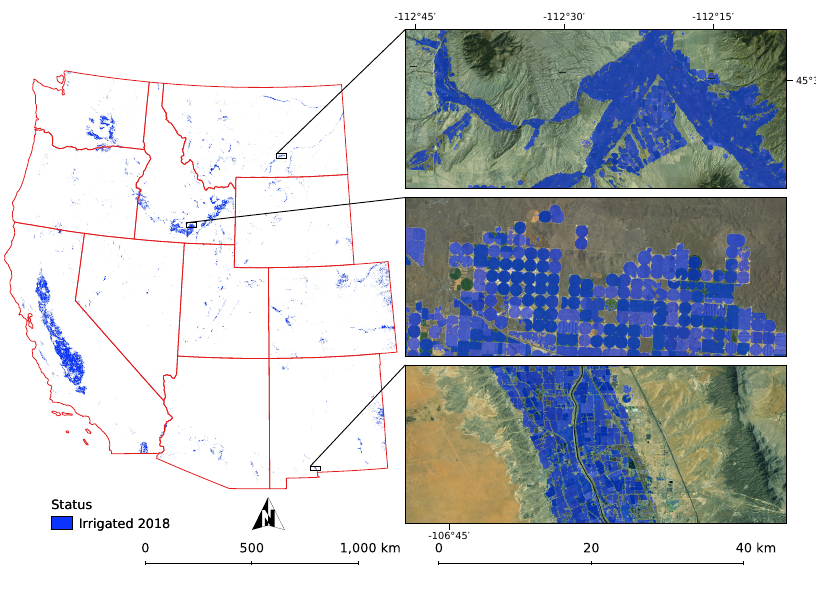
Figure 6. Irrigation status as predicted for the year 2018 by IrrMapper, at 30-m